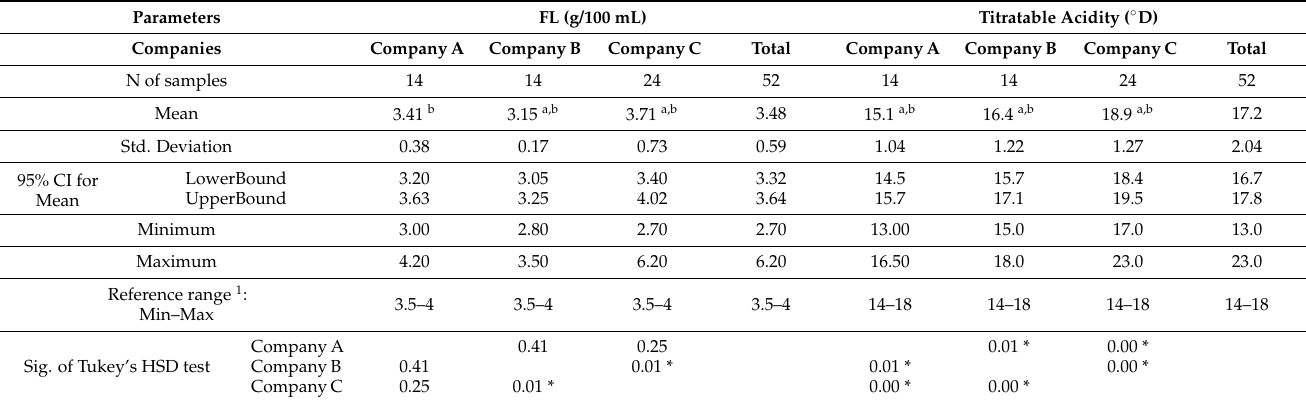
Table 5. Analysis of FL and titratable acidity variances across